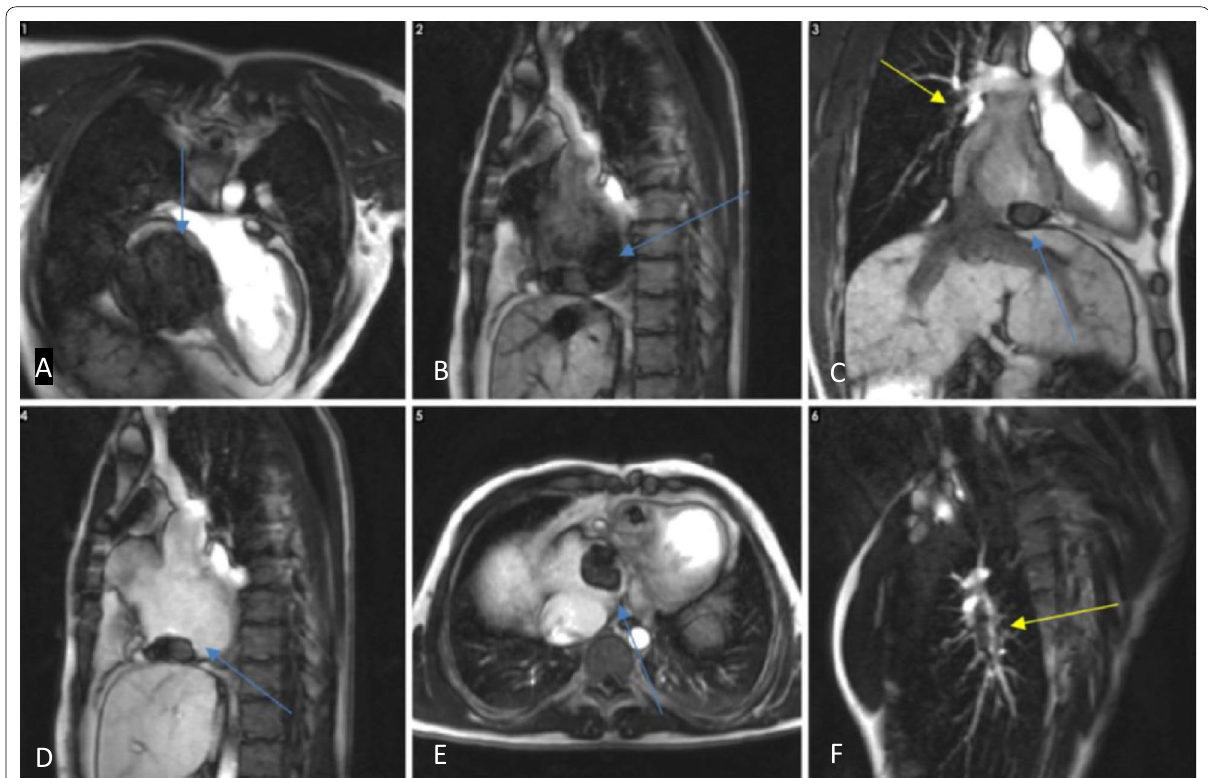
Fig. 24 Horizontal long-axis ( A ), sagittal ( B , D ), coronal ( C ), axial ( E ) and right pulmonary artery cross-cut views ( F ) of a cardiovascular MRI study in an atriopulmonary Fontan circulation performed for congenital tricuspid atresia. There are filling defects in keeping with thrombi in the right atrium (blue arrows) and in the right pulmonary artery (yellow arrows) on inversion recovery early-phase gadolinium sequences. Note that thrombus appears as very hypointense. Re-used with permission from Fontan circulation in an adult: A guide for the radiologist. Arzanauskaite M, Nyktari E, Voges I. ESTI-ESCR